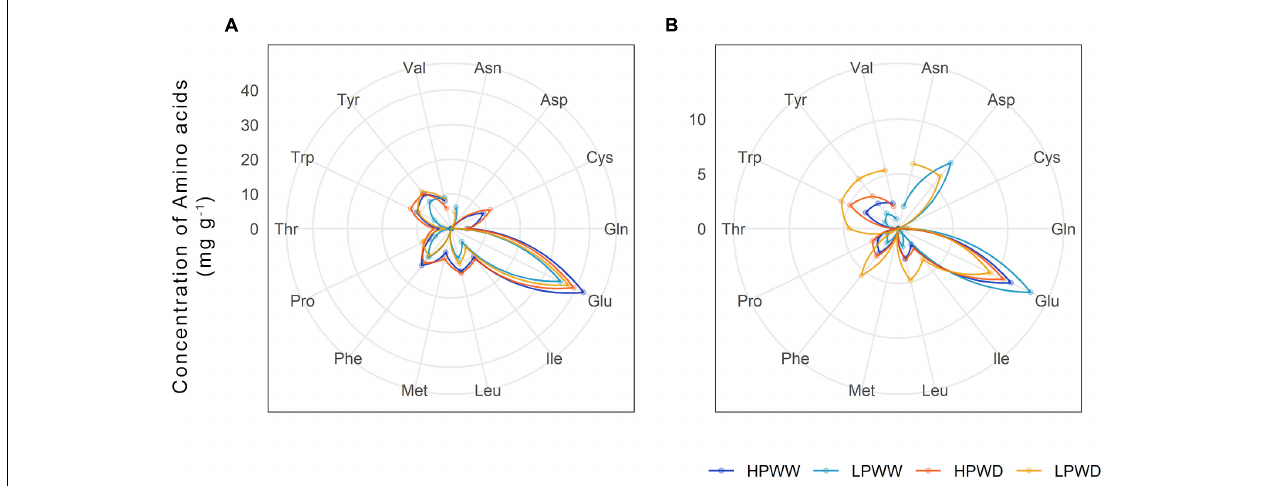
FIGURE 6 | The concentration of amino acids (mg/g) found in common bean soluble leaf fraction subjected to high phosphorus well-watered (HPWW; blue), low phosphorus well-watered (LPWW; light blue), high phosphorus water deficit (HPWD; orange), and low phosphorus water deficit (LPWD; yellow-orange) at flowering (A) and mid-pod fill (B) . Data has been transformed for visualization purposes. Only Glu had a significant concentration level ( P = 0.000) compared to other amino acids at all treatments at flowering and mid-pod